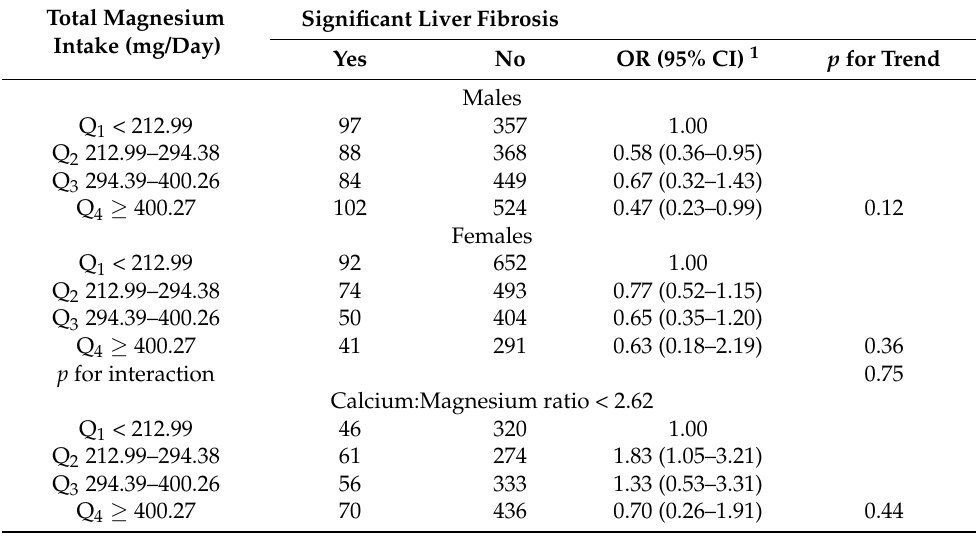
Table 3. Associations between intake of total magnesium and odds of significant fibrosis by